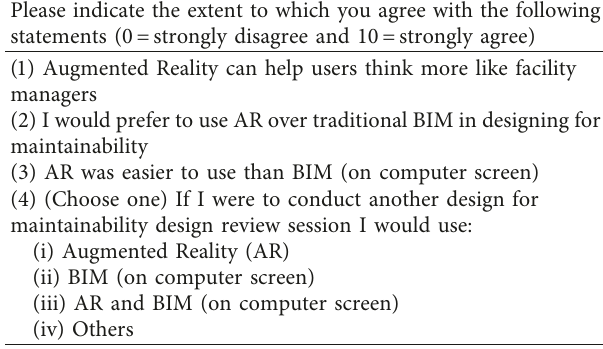
Table 4: Final questionnaire